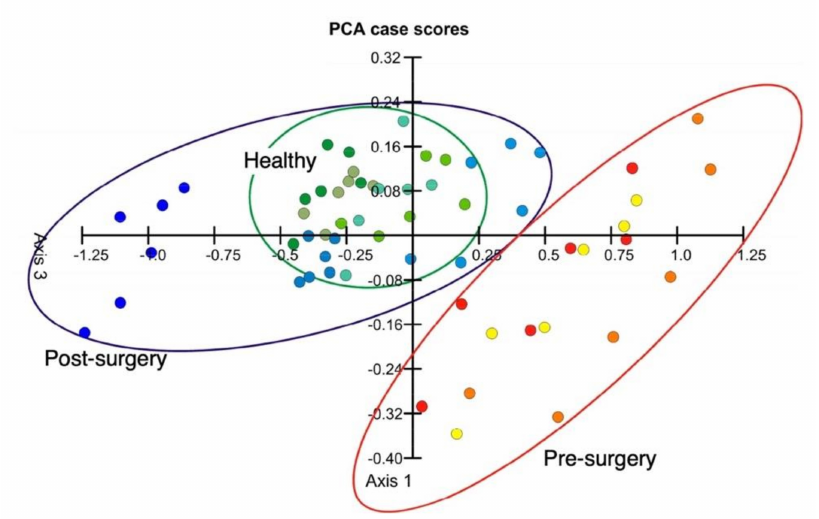
Figure 18. PCA scatter plot showing three distinct clusters representing healthy control persons, head and neck squamous cell carcinoma patients before and after surgery. Reprinted from Ref. [156], the author licensed under CC-BY